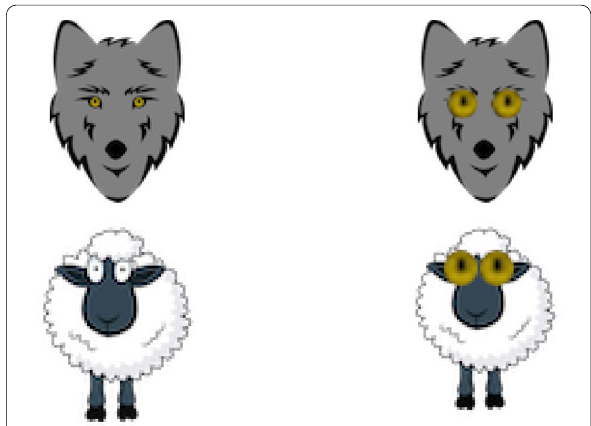
Fig. 5 Examples of object changes used in Experiment 2 to signal a pause in feeding, either due to “danger” for hunted participants (Wolf object) or over-feeding for distracted participants (Sheep